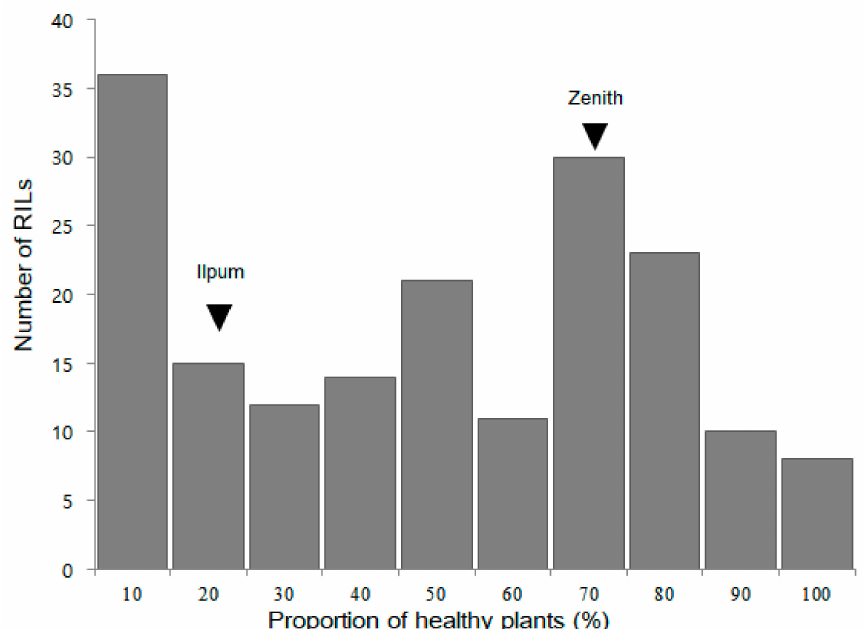
Figure 3. Frequency distribution of the proportion of healthy F 2:9 plants derived from a cross between Ilpum and Zenith after bakanae disease inoculation. The mean proportion of healthy plants of Ilpum and Zenith are indicated by black arrow heads.